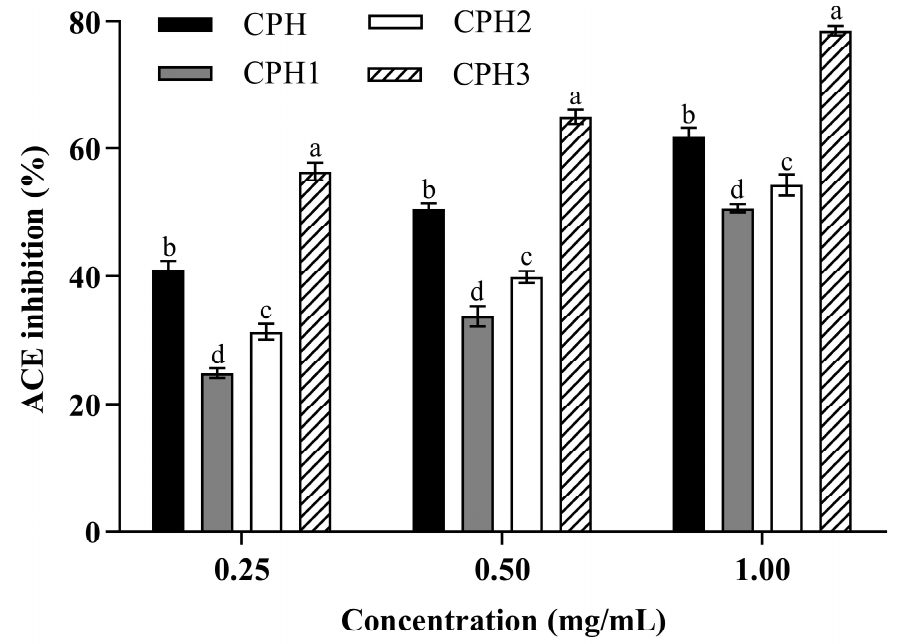
Figure 2. ACE inhibitory activity of CPH and its three ultrafiltration fractions (CPH1 to CPH3). The results are presented as the means ± SD (n = 3). Different letters indicate significant differences at p < 0.05.